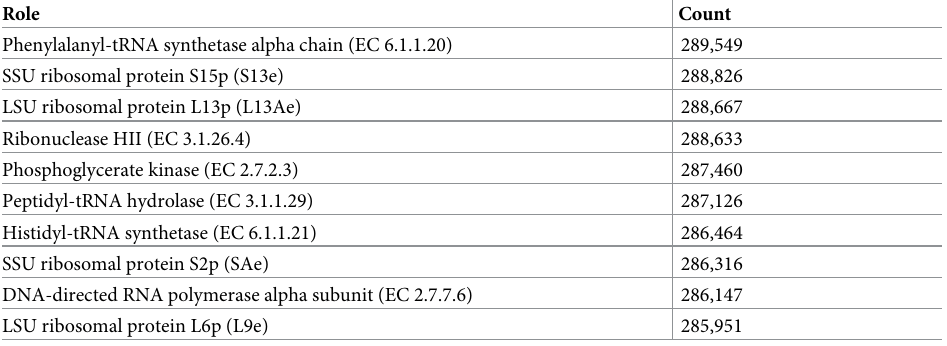
Table 1. Most common roles in PATRIC. The top 10 most commonly-occurring single-copy roles in PATRIC, along with their counts. pheS is consistently the most common role, whereas others shift around. pheS was chosen because of its abundance in PATRIC and good performance as a seed protein in the binning